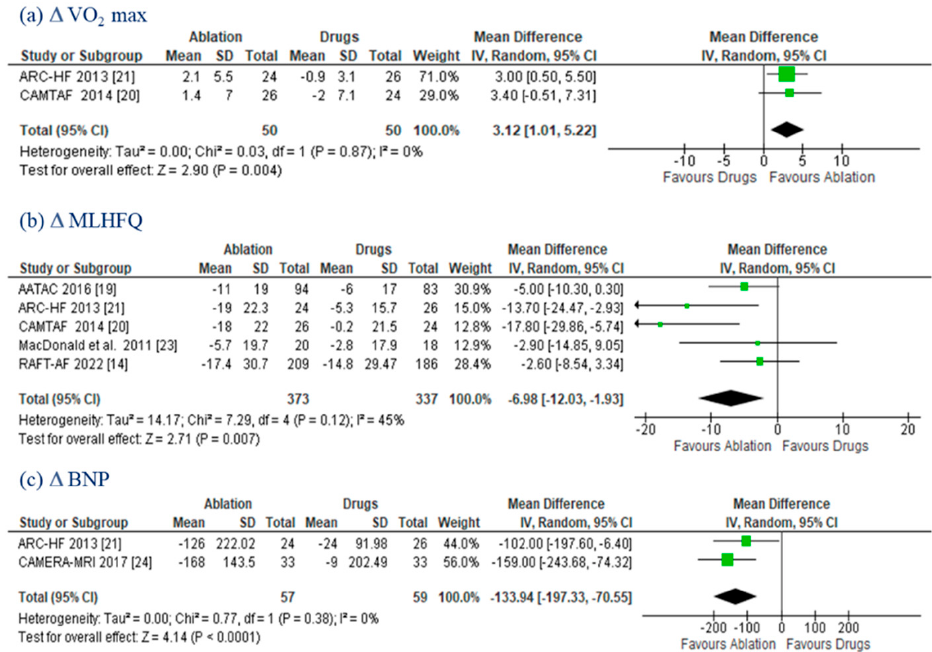
Figure 5. VO 2 max, MLHFQ, and BNP. Forest plots displaying mean differences in VO 2 max ( a ), MLHFQ ( b ), and BNP ( c ) between the ablation and drug groups. CI: confidence interval; MLHFQ: Minnesota Living with Heart Failure Questionnaires; SD: standard deviation; VO 2 Max: peak oxygen consumption.